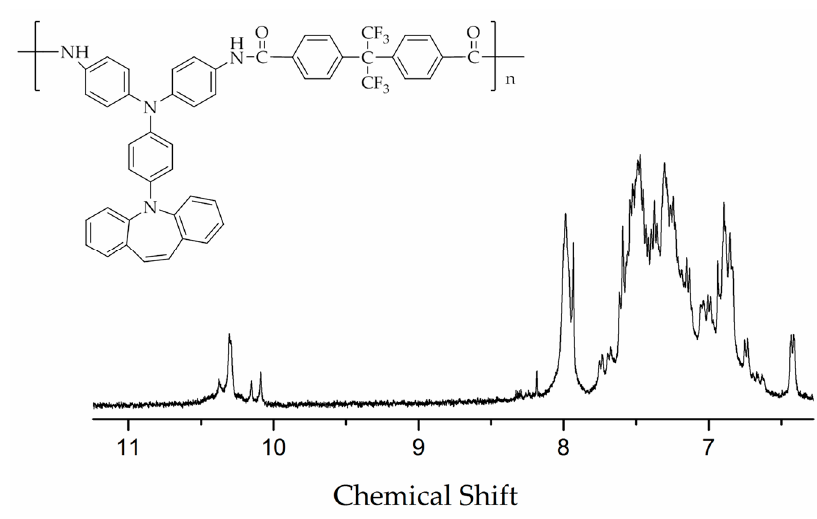
Figure A7. 1 H NMR spectrum of PA–d in DMSO- d 6 .